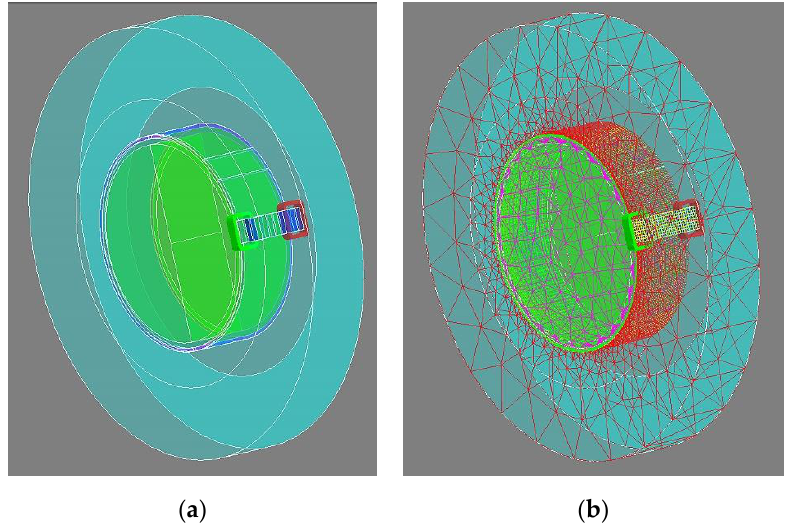
Figure 7. The calculation domain of the inductors — rotating cylinder system: volume regions ( a ), meshing of volume regions ( b ).